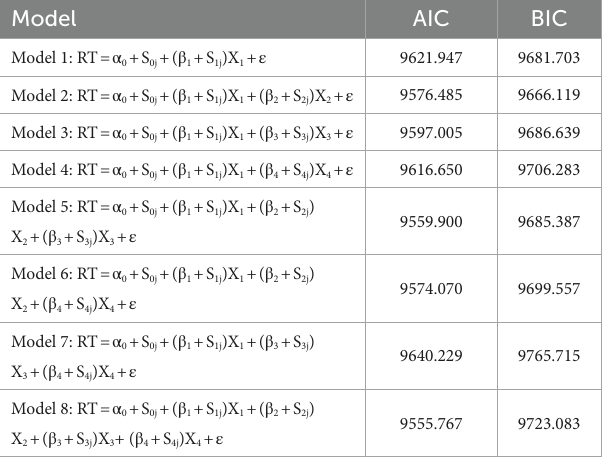
TABLE 1 Models used for the generalized linear mixed model (GLMM) analyses and the model selection by the Akaike information criterion (AIC) and the Bayesian information criterion